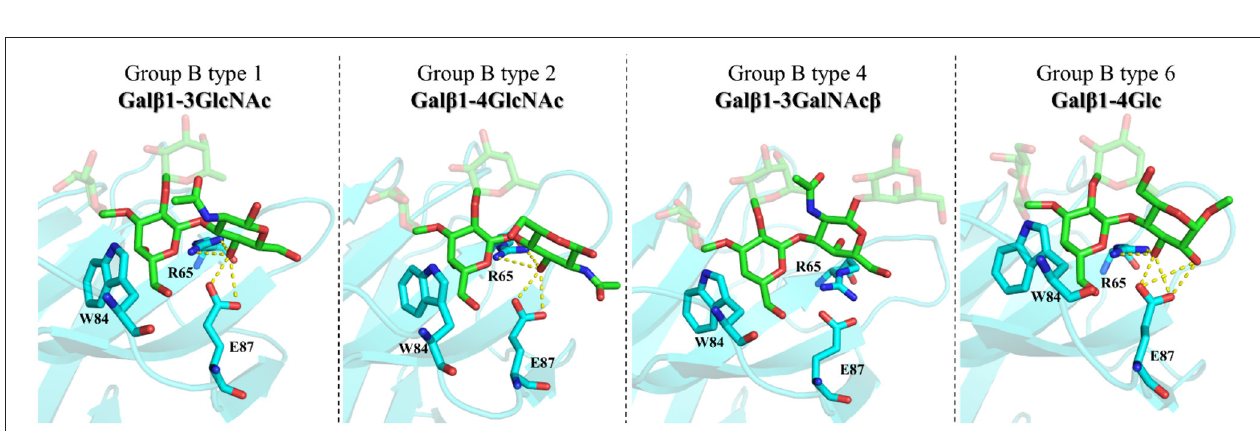
FIGURE 7 | Different perspectives of the superimposition of the 3D models for the complexes Gal-4N/A type-6 (orange) and Gal-4N/B type-6 (green) according to the MD simulations. Reducing-end and Fuc residues are faded. Key residues of the protein are highlighted.